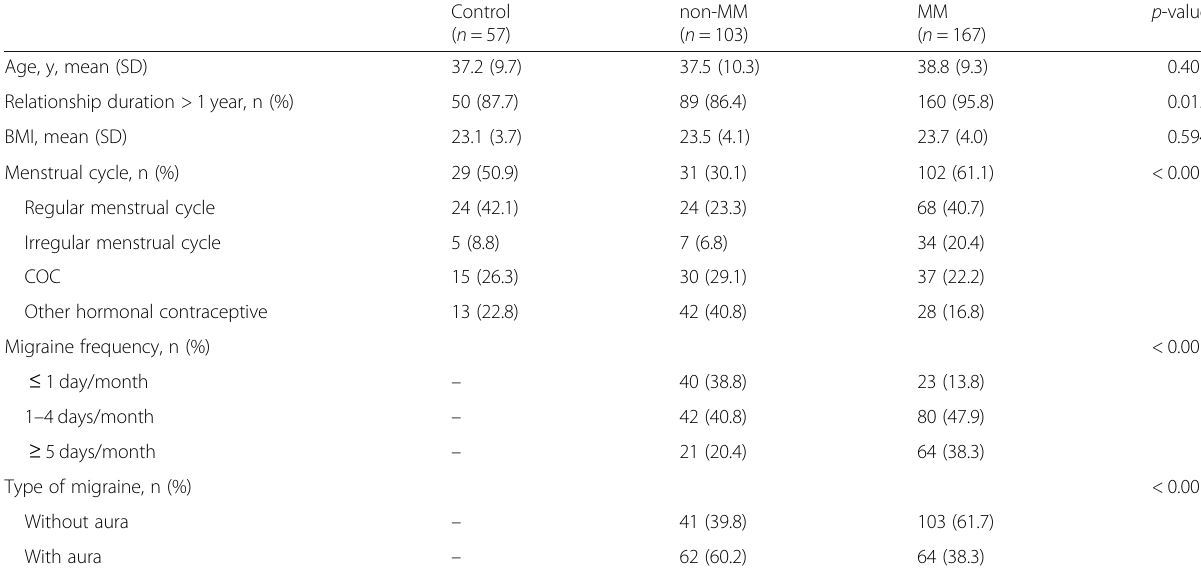
Table 1 Characteristics of the premenopausal study population